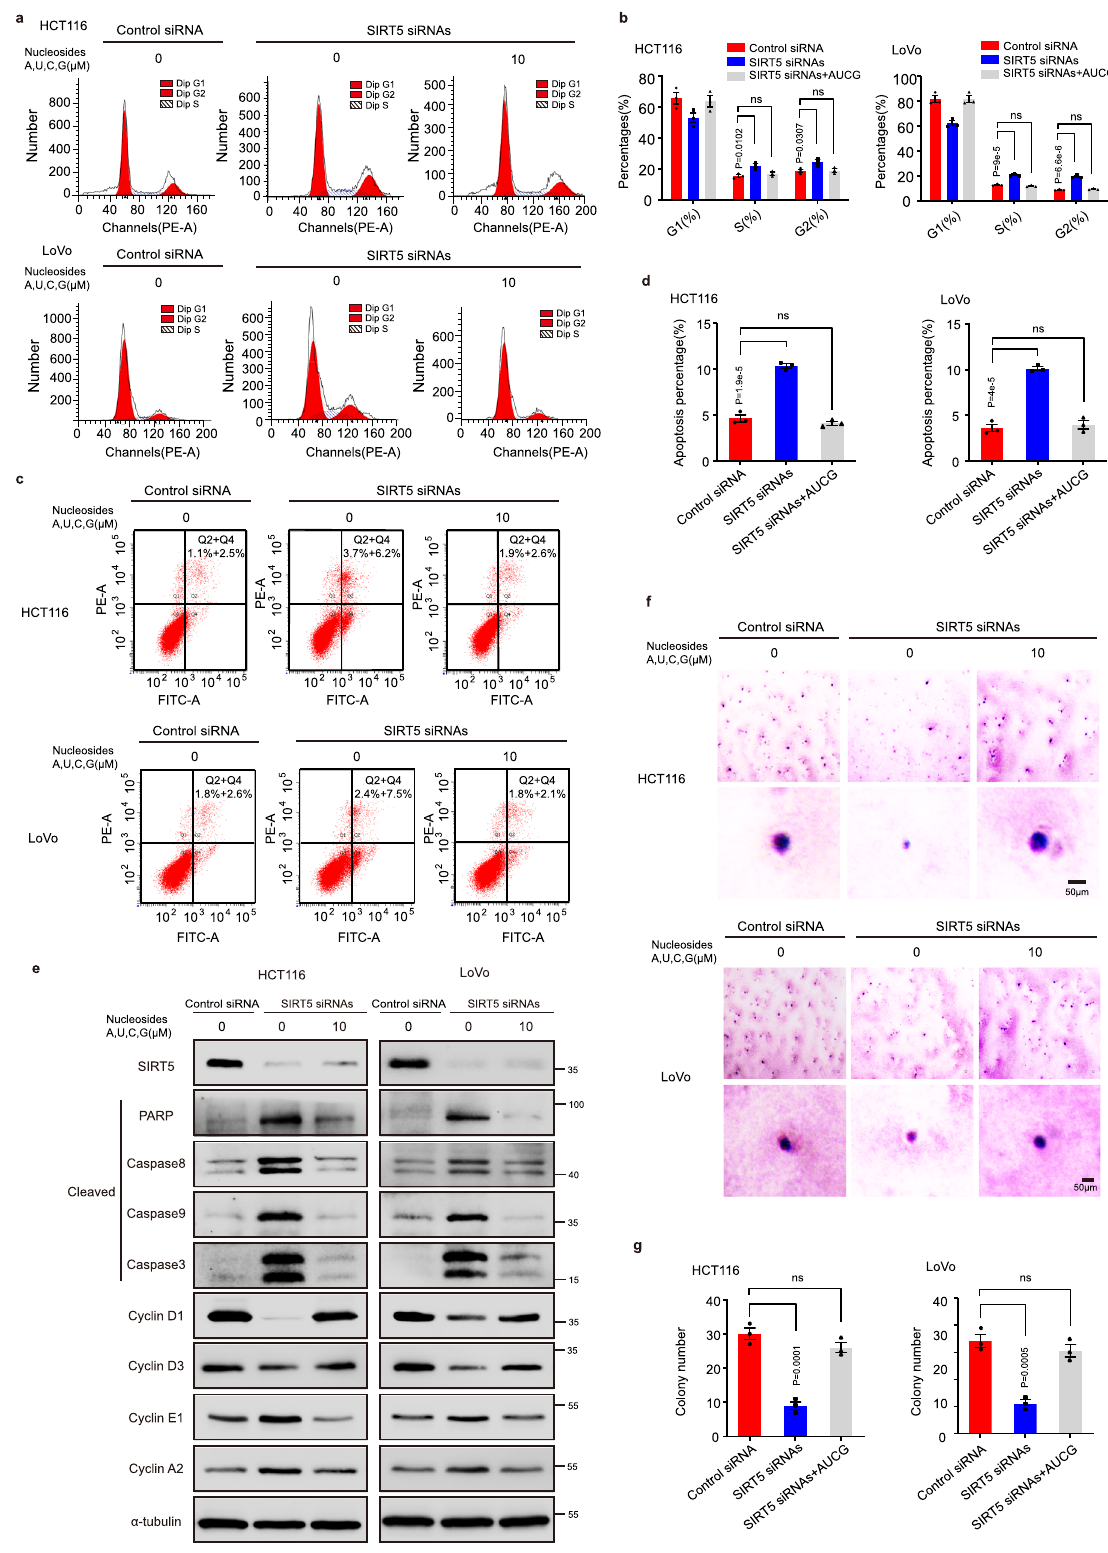
Fig. 3 | Exogenous nucleoside supplementation reduces the effects of SIRT5 silencing on cell cycle, apoptosis, and colony formation in CRC cells. a – d The fl ow cytometry was used to detect changes in the cell cycle ( a ) and apoptosis ( c ) in SIRT5-de fi cient HCT116 and LoVo cellswith exogenous nucleoside supplementation for16h. The data in( a and c ) werequanti fi edand analyzed in( b ) and ( d )respectively. e Theexpression of apoptosis indicators(the cleaved caspase 8, caspase 9, caspase 3, and PARP) and cell cycle regulators in SIRT5-silenced CRC